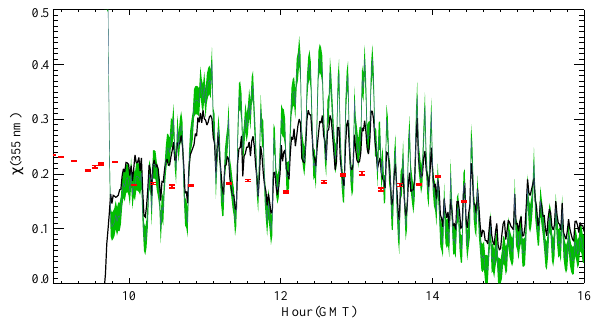
Fig. 16. Retrieved aerosol optical thickness at 355 nm (grey/green) compared to that observed by AERONET at level 2.0 (red) for 2 March 2010. The analogue Ansmann solution integrated between 0.25 and 2 km is shown in black.